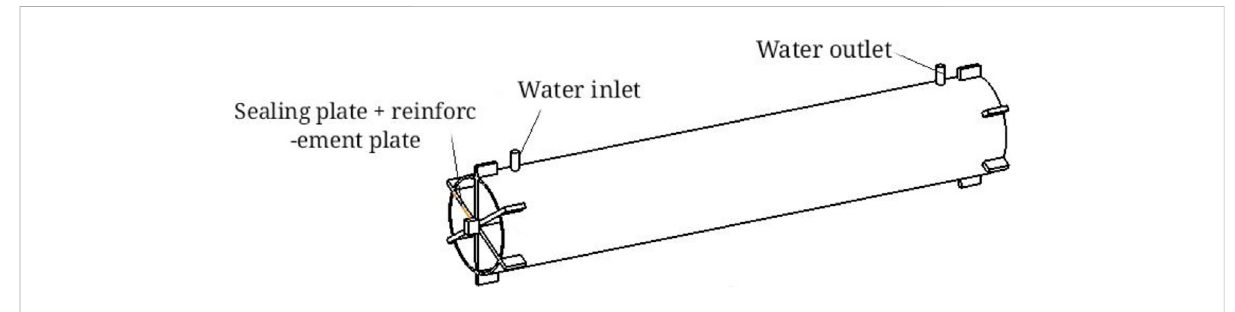
FIGURE 2 The diagram of the pipe sample for the hydrostatic bursting